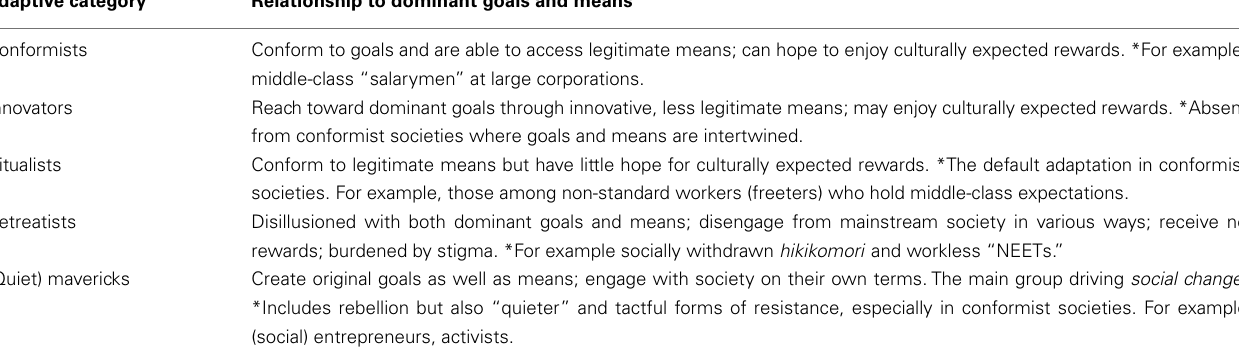
Table 1 |The adaptive categories available to youth in relation to dominant cultural success goals and legitimate institutional means. (Examples from Japan marked with an